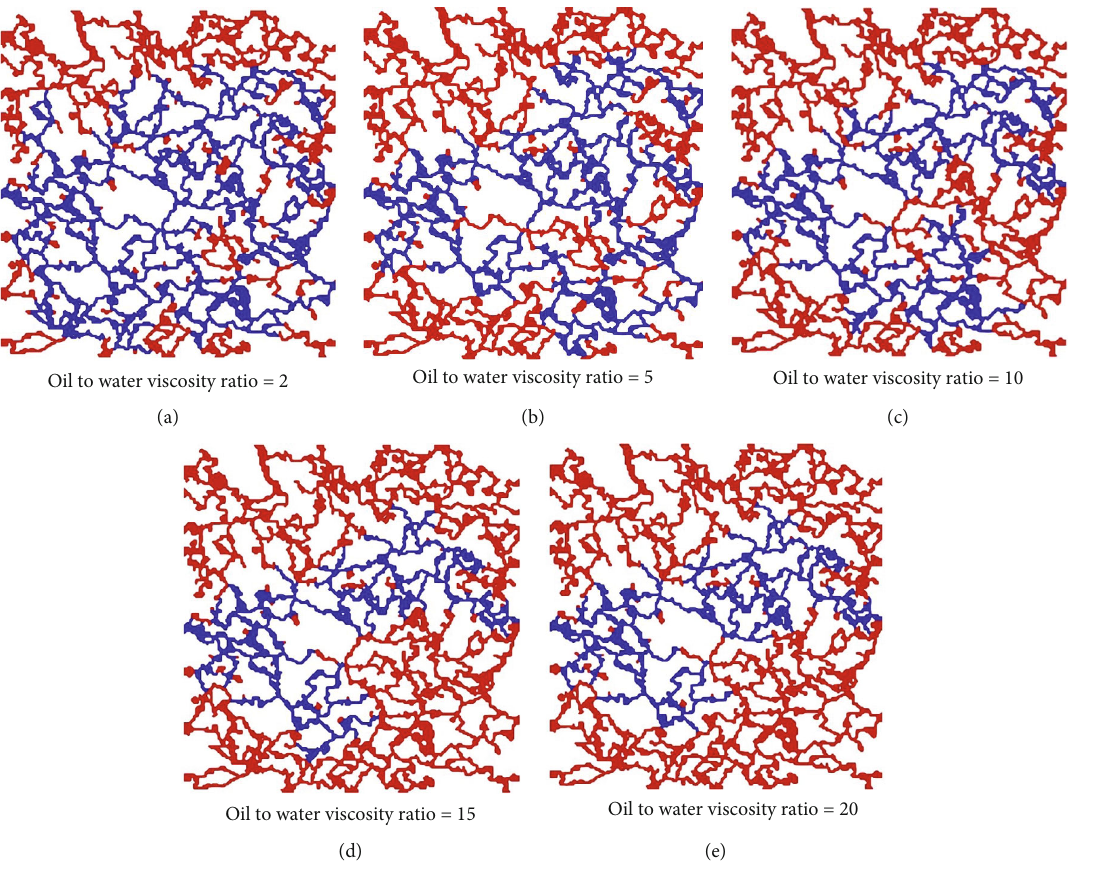
Figure 8: Oil and water two-phase distribution versus viscosity. (a) Oil − to − water viscosity ratio = 2 . (b) Oil − to − waterviscosity ratio = 5 . (c) Oil − to − waterviscosity ratio = 10 . (d) Oil − to − waterviscosity ratio = 15 . (e) Oil − to − waterviscosity ratio = 20 .